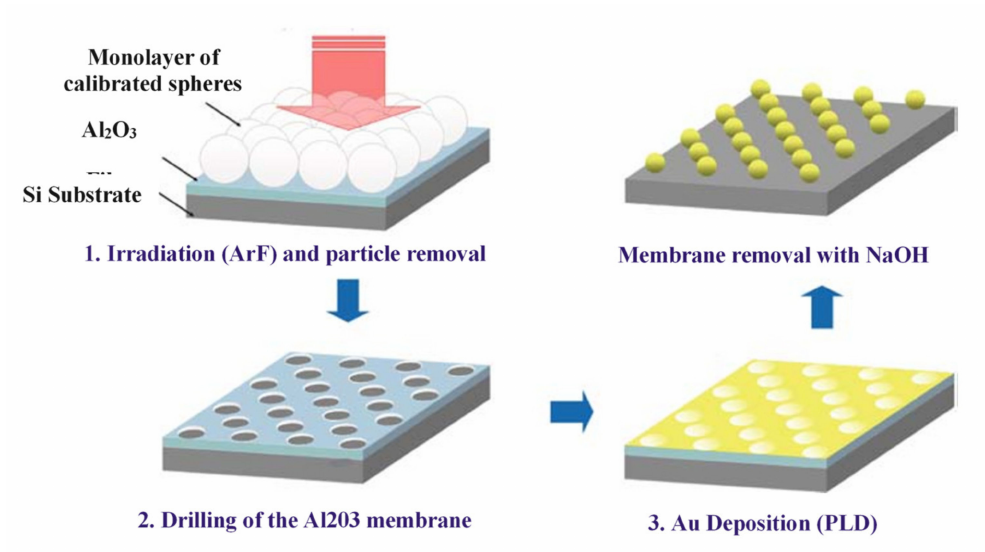
Figure 3. Preparation of ordered Au nanodot arrays by laser pulse irradiation. Adapted from [62],